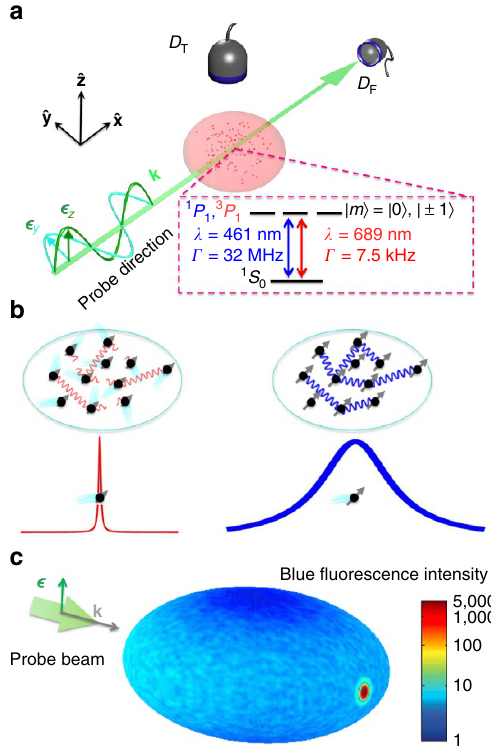
Figure 1 | The experimental scheme and concept. ( a ) We weakly excite the strontium atoms with a linearly polarized probe beam and measure the fluorescence with two detectors: one in the forward direction, ^ x , and the other almost in the perpendicular direction, ^ z . We probe two different J ¼ 0 to J ’ ¼ 1 transitions. The first transition is a 1 S 0 (cid:2) 1 P 1 blue transition with a natural linewidth of G ¼ 32MHz and the second is a 1 S 0 (cid:2) 3 P 1 red transition with G ¼ 7.5kHz. ( b ) In the coherent dipole model, photons are shared between atoms. When the Doppler broadened linewidth becomes comparable to the natural linewidth, dephasing must be considered. At our B 1 m K temperatures the Doppler broadening is E 40kHz, meaning motional effects are important only for the red transition. ( c ) The three- dimensional intensity distribution predicted for a blue probe beam. The coupled dipole model predicts a strong 10 3 enhancement of the forward intensity compared with other directions and a finite fluorescence along a direction parallel to the incident polarization. The speckled pattern is due to randomly positioned atoms and can be removed by averaging over multiple atom